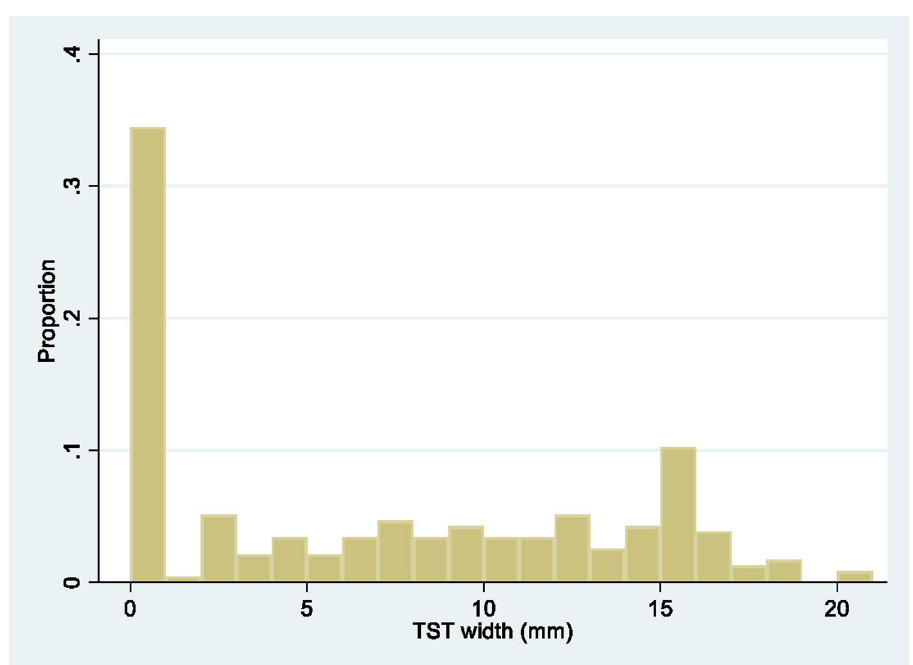
Fig 2. Distribution of TST responses (n = 235). TST = tuberculin skin